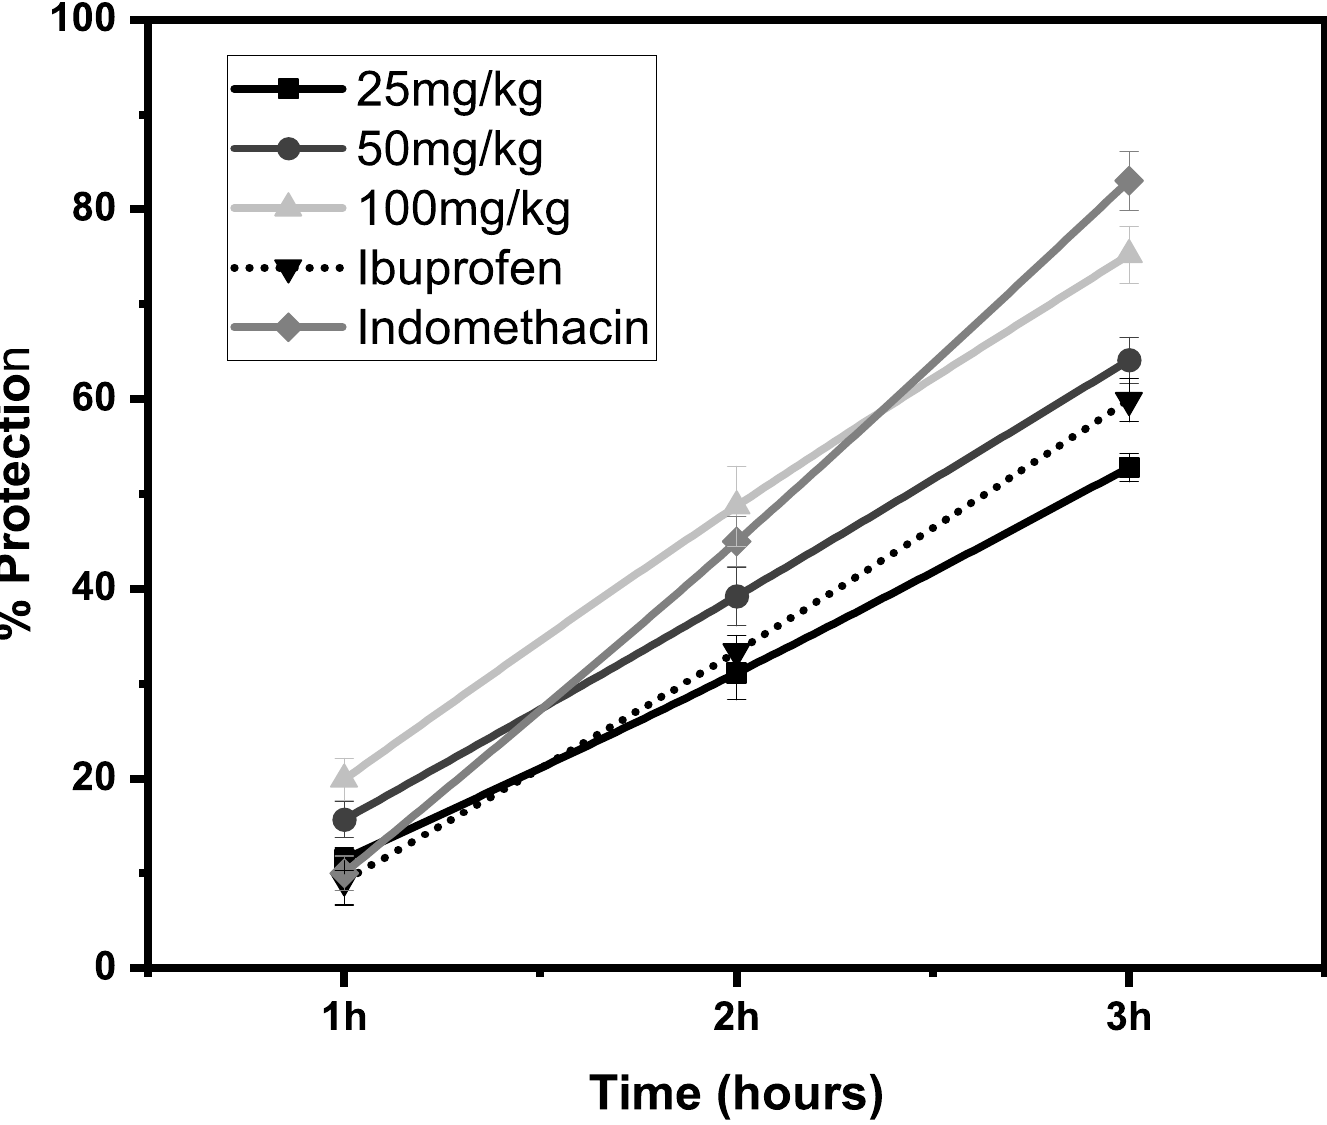
Fig 5. Anti-inflammatory activity of S . cumini leaves extract on carrageenan induced paw edema. Data is expressed as Mean ± SEM (n = 3).